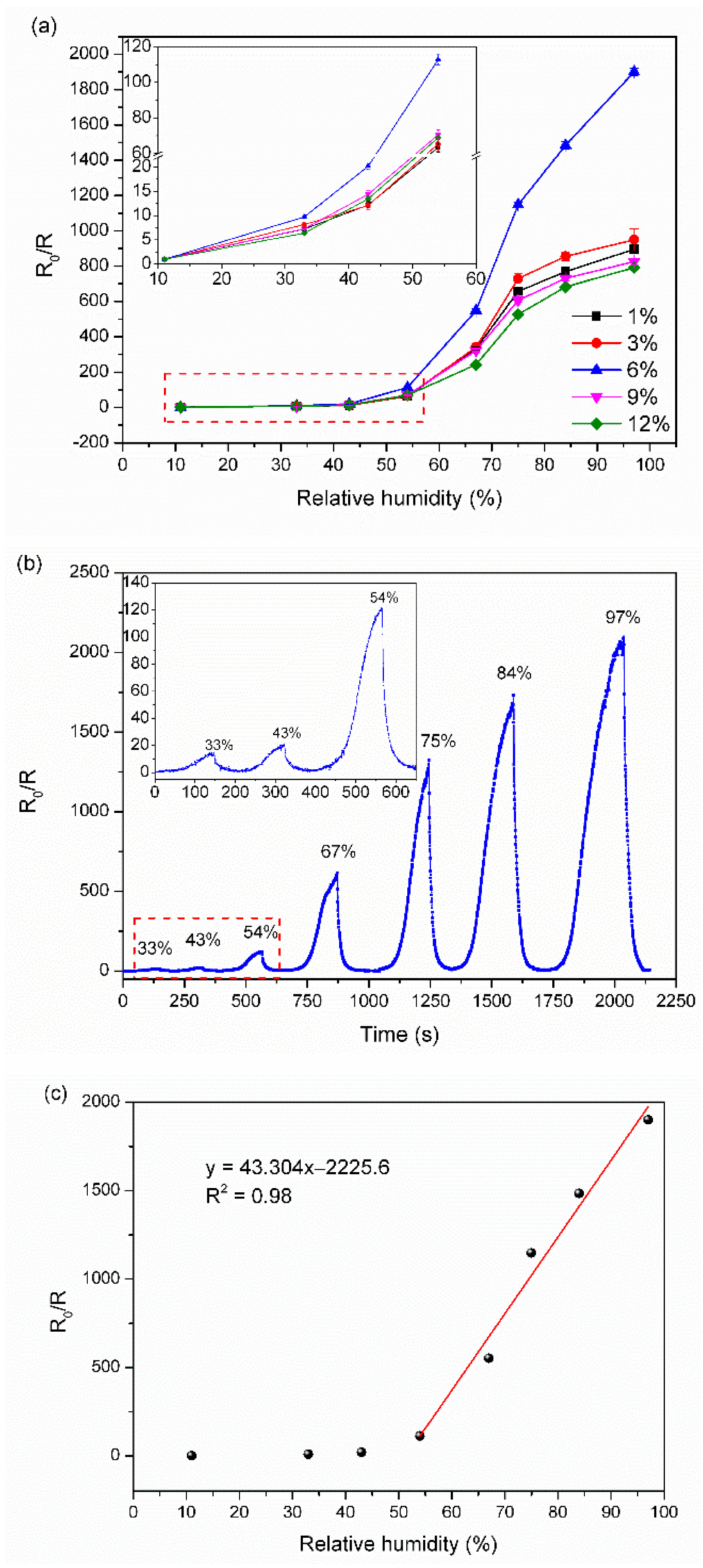
Figure 4. ( a ) Variations in humidity responses of TiNP/CNC composite film sensors with different TiNP contents. ( b , c ) Dynamic response and calibration curves of the 6% TiNP/CNC-based humidity sensors under 11–97% RH